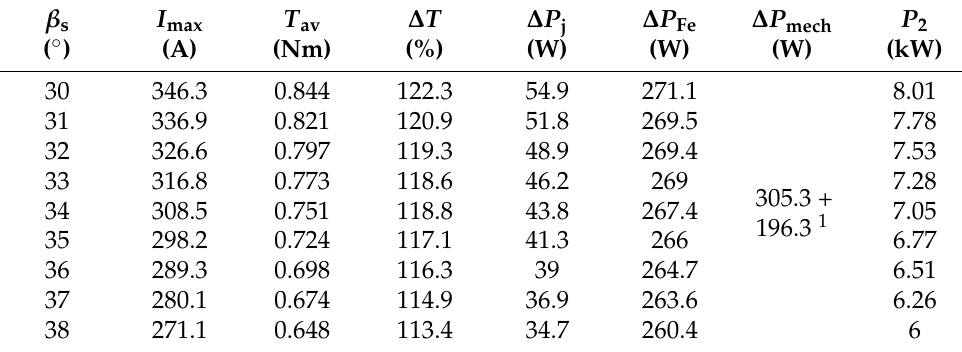
Table 8. Results of the analysis of the stator pole